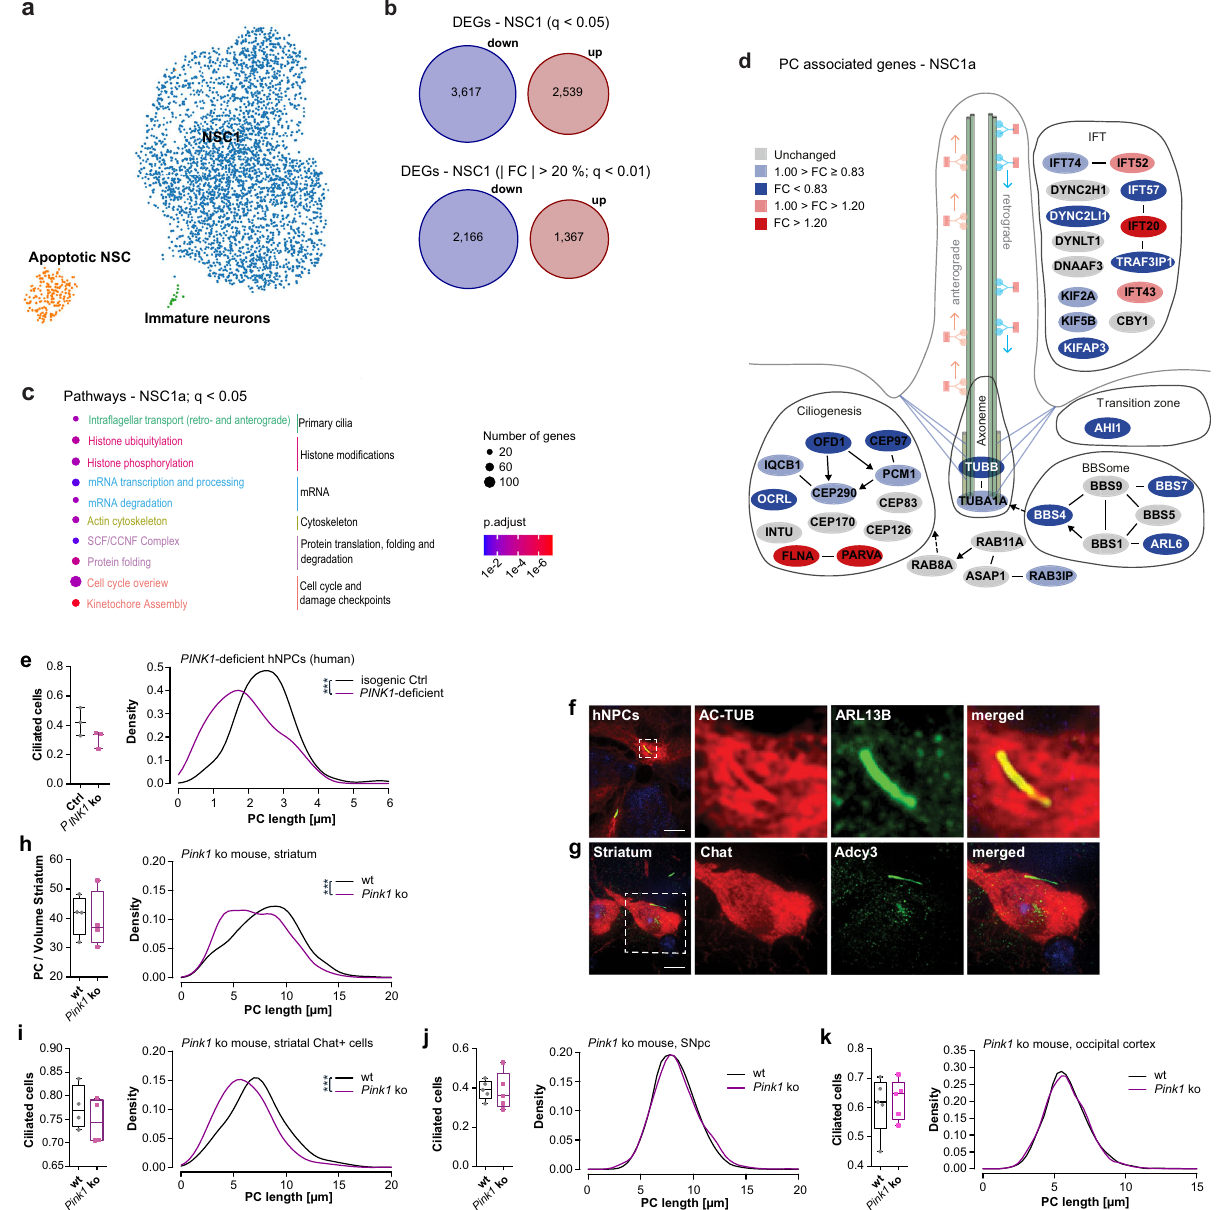
Fig. 9 | Primary cilia in fPD. a UMAP visualization of 3671 annotated cells from a PINK1 koandisogenicCtrlhNPCcelllinewithinthe clustersNSC:neuralstemcells, apoptotic NSC, and immature neurons. b Number of all and most (| FC|>20%; q <0.01) up- and downregulated DEGs in the NSC1 cluster. FC, fold change. c Enriched pathways of the categories Cell process analyzed using Pathway Studio for the DEGs of the NSC1 cluster. P -values were determined by one-sided Fisher ’ s exact tests. FDR corrected p -values are represented by q -values. d Visualization of the “ Intra fl agellar transport: BBSome interaction ” pathway with manual annota- tions. Up- (red) and downregulated (blue) genes are sorted into functional cate- gories intra fl agellar transport (IFT), transition zone, BBSome, axoneme, and ciliogenesis. Color intensity is proportional to fold change. e (right) Density plot illustrating the distribution of PC length (in µ m) in a hNPC population. (left) Frac- tion of ciliated cells. PC length was measured in immunostainings of PINK1 ko and isogenic Ctrl hNPCs with anti-ARL13B. n =38-89 cilia per clone and replicate (three independent differentiations). f PC immunostaining with anti-AC-TUB and anti- ARL13B exemplarily shown for isogenic Ctrl of PINK1 ko hNPCs. g PC immunos- tainingwithanti-Chatandanti-Adcy3exemplarilyshownfora Pink1 komice. h (left) Fraction of ciliated cells(in a striatalvolume of 115 µ m x 87 µ mx40 µ m) and (right)